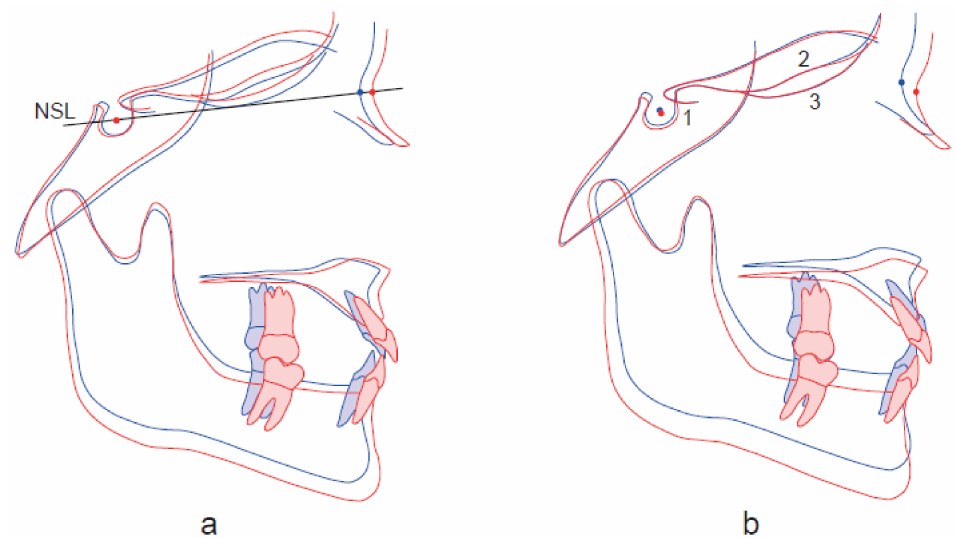
Figure 4. Illustration of how superimposition using the SN method ( a ) overestimates the sagittal relation and underes- timates the vertical relation, due to displacement of the nasion (T1 T2) forwards and downwards, as compared to the superimposition-based cephalometrics using Björk’s structural method ( b